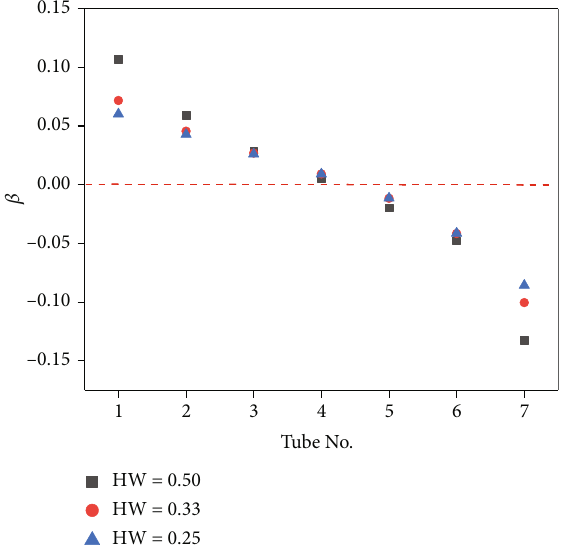
Figure 9: Outlet fuel temperature with di ff erent α values.